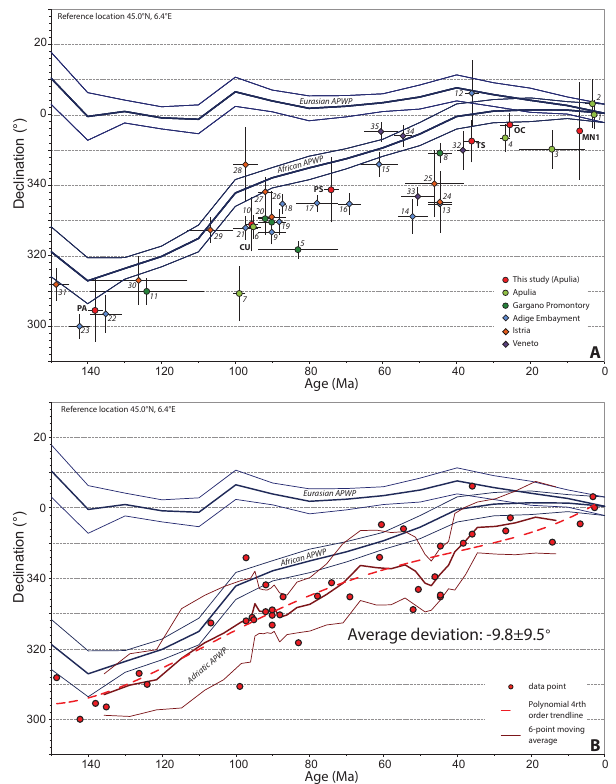
Figure 7. (A) Age (Ma, following the timescale of Gradstein et al., 2012) vs. declination plot for our new as well as published data from Adria. The error envelopes for the African and Eurasian APWPs are from Torsvik et al. (2012). Vertical error bars correspond to the 1D calculated at each site (Table 1); horizontal error bars correspond to age uncertainty. All data are recalculated to a reference location (45.0 ◦ N, 6.4 ◦ E) corresponding to the Neogene Apulia–Africa Eu- ler pole proposed by Ustaszewski et al. (2008). Numbers and site abbreviations correspond to data entries in Table 1. (B) Same data, with a polynomial fourth-order trend line (purple dashed line) and the declination component of a full-vector six-point moving average with error bars ( 1D ) (red